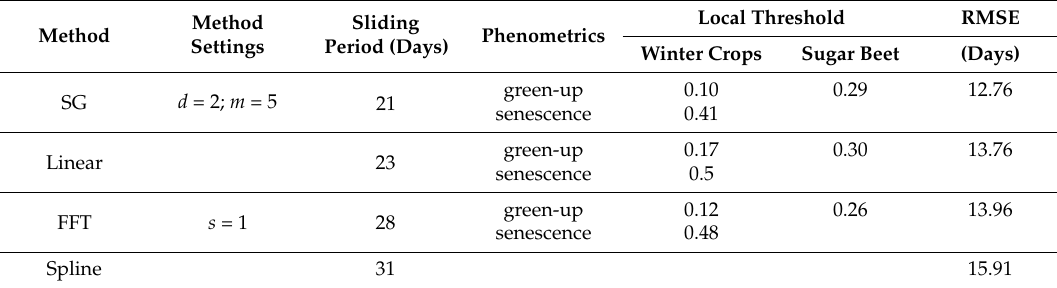
Table 2. Calibrated sliding period and thresholds for four methods with field data in 2010, 2011, 2012 and 2014. RMSE in days was calculated with all phenostages of all four crops. d and m represent the degree of polynomial fitting and the middle width of the moving window, respectively. s is the smoothing intensity of fast Fourier transform (FFT).